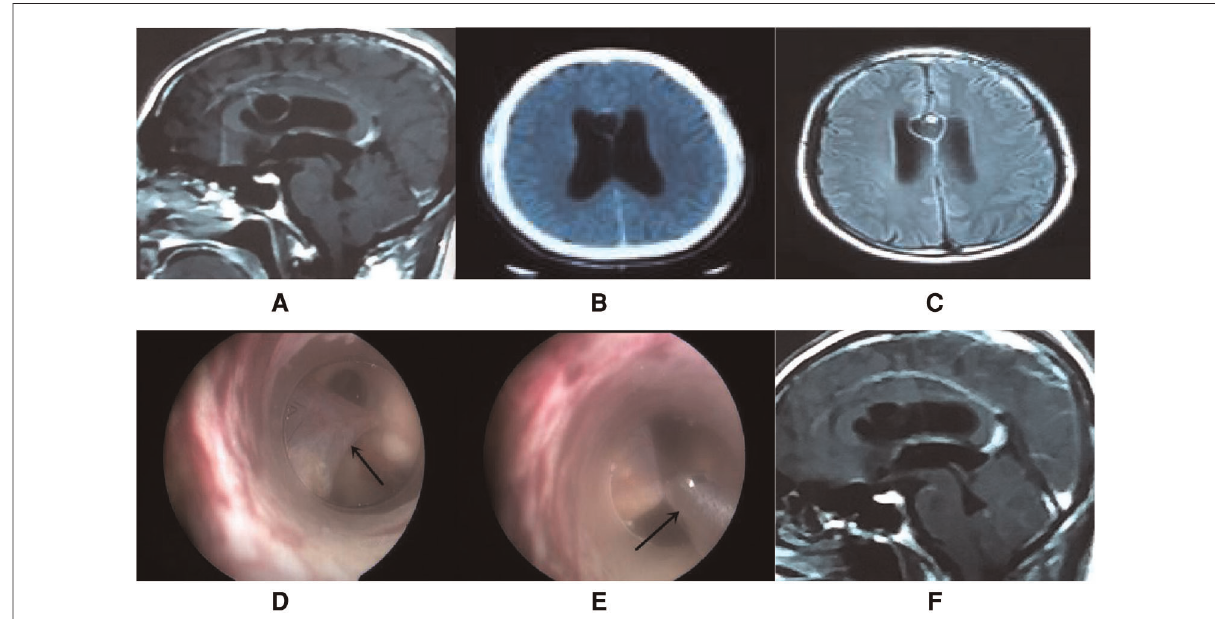
FIGURE 2 Endoscopic intraventricular surgery was performed to remove a cystic lesion and perform ETV in case 1. ( A – C ) CT and MRI scans showing a cystic lesion with moderate enhancement in the septum pellucidum with a large ventricle. ( D ) Surgical image showing the cystic lesion (arrow point) in the septum pellucidum and connected to the ependyma overlying the caudate. ( E ) Surgical image showing how nasal forceps (arrow point) were used to remove the cystic lesion. ( F ) MRI scan showing that the enhanced cystic lesion had disappeared by day 5